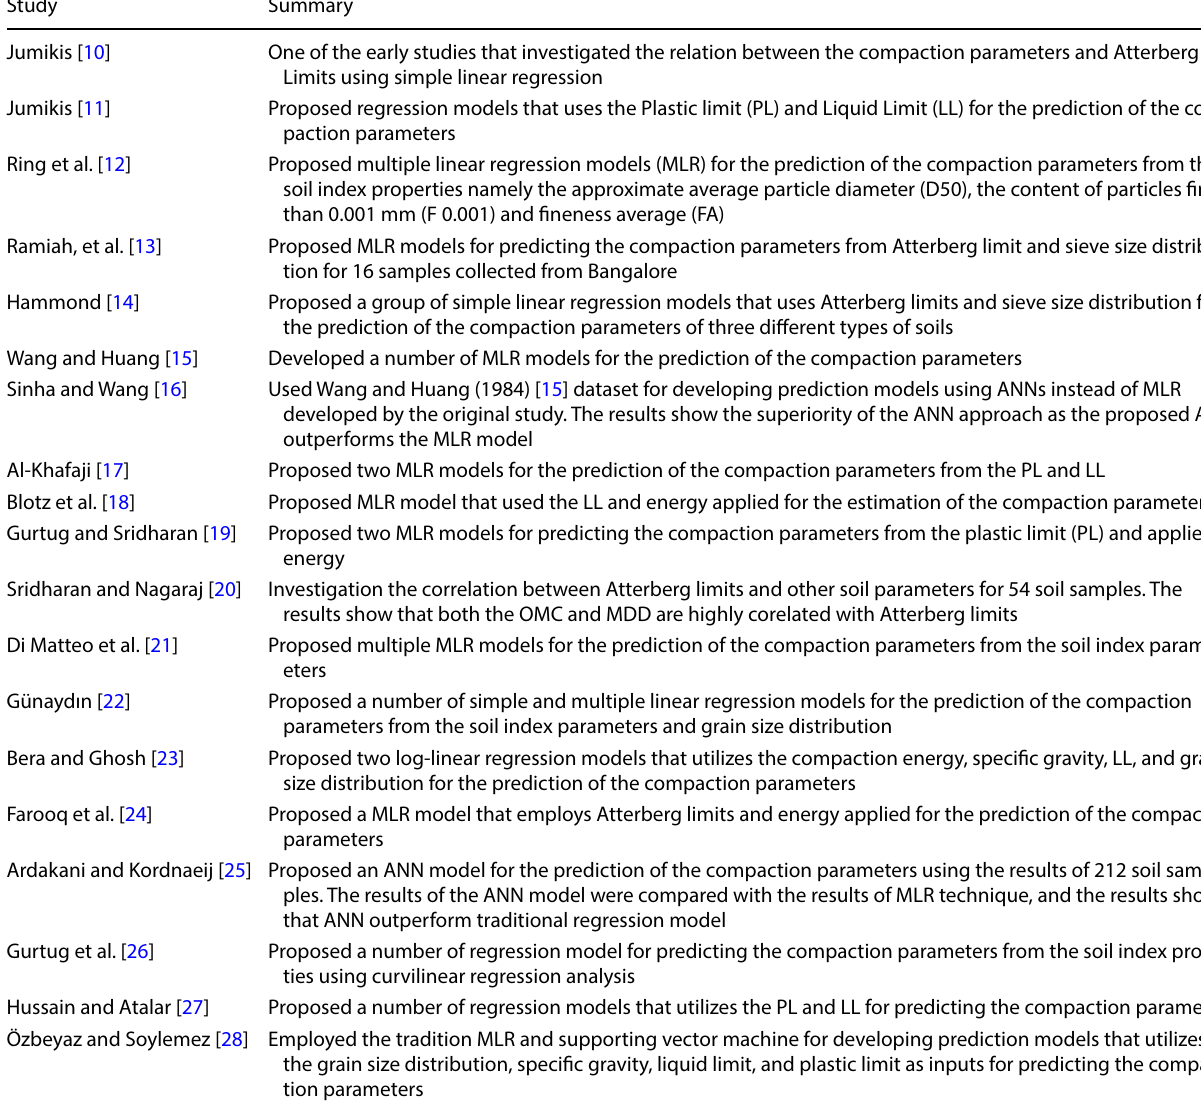
Table 1 Summary of previous studies that proposed prediction models for the compaction